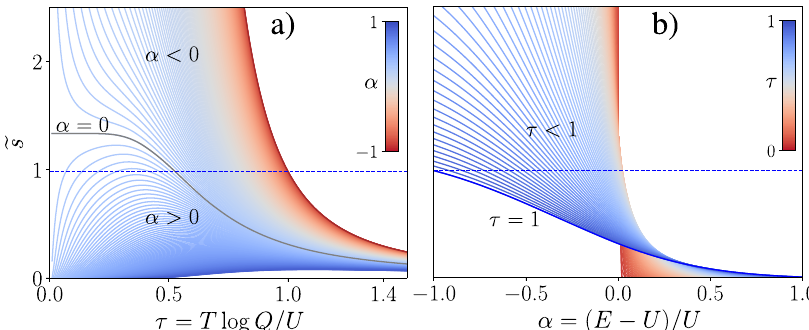
Fig. 2 Renormalized stability parameter. Projections of e s ð τ ; α Þ at fi xed values of one of parameters, shown on the colorbar. a e s ð τ Þ at different α s (temperature dependence at different energies). b e s ð α Þ at different τ s (energetic dependence at different temperatures). COMMUNICATIONS CHEMISTRY| (2021) 4:57